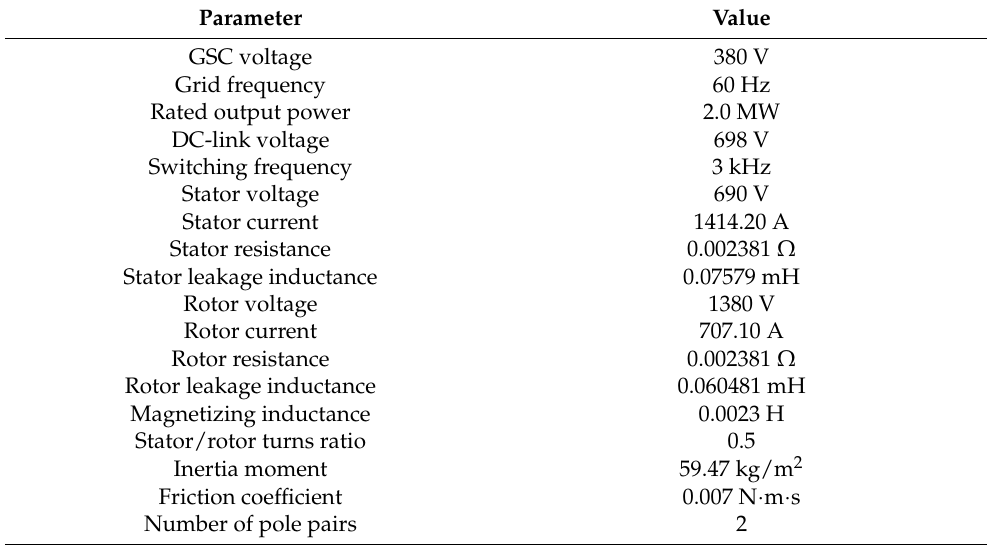
Table 1. Specifications of the simulated system